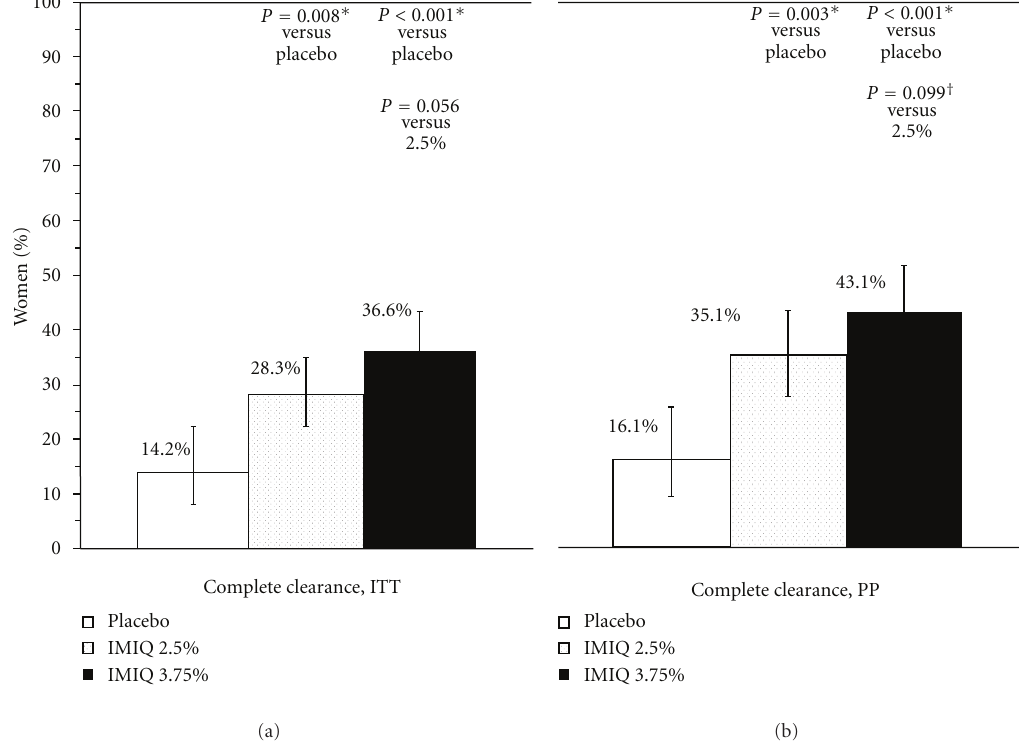
Figure 2: Complete clearance rates. (a) Intent to treat (b) per protocol. White: placebo, stippled: imiquimod 2.5%, solid black: imiquimod 3.75%. P -values from a Cochran-Mantel-Haenszel test, stratified by analysis site using two treatment groups at a time. ∗ indicates statistically significant for active versus placebo, and † for imiquimod 3.75% versus 2.5%, using Hochberg’s modified Bonferroni procedure. Bars indicate 95% confidence interval calculated using exact